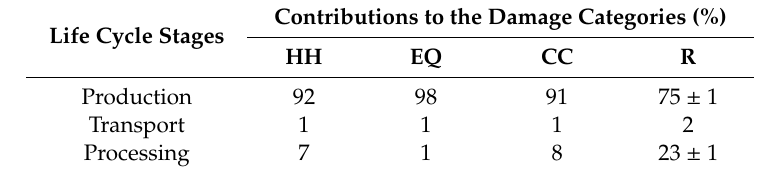
Table 7. Mean contributions of the raw milk life cycle to each damage category for scenarios A, B, and C 1